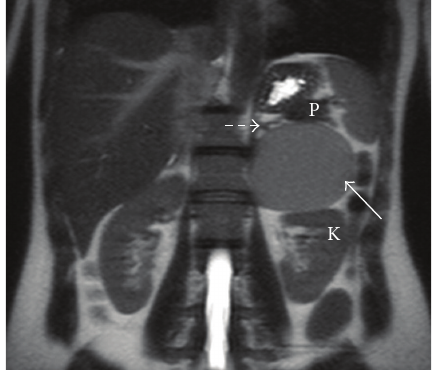
Figure 3: Coronal T2-weighted (TR-600ms; TE-83 ms) MR image shows cyst contents of intermediate signal intensity (arrow). The lesion is located between the pancreatic tail (P), the left kidney (K), and the left adrenal gland (dashed arrow).